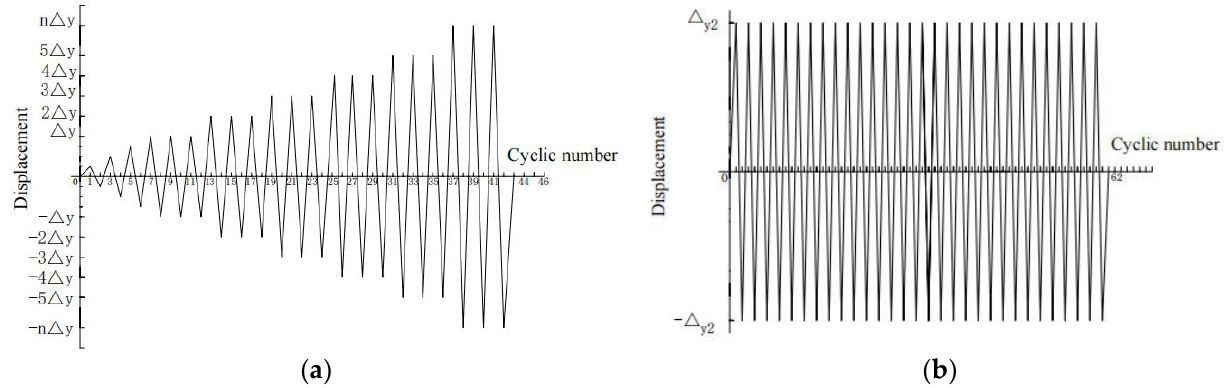
Figure 5. Test set-up.